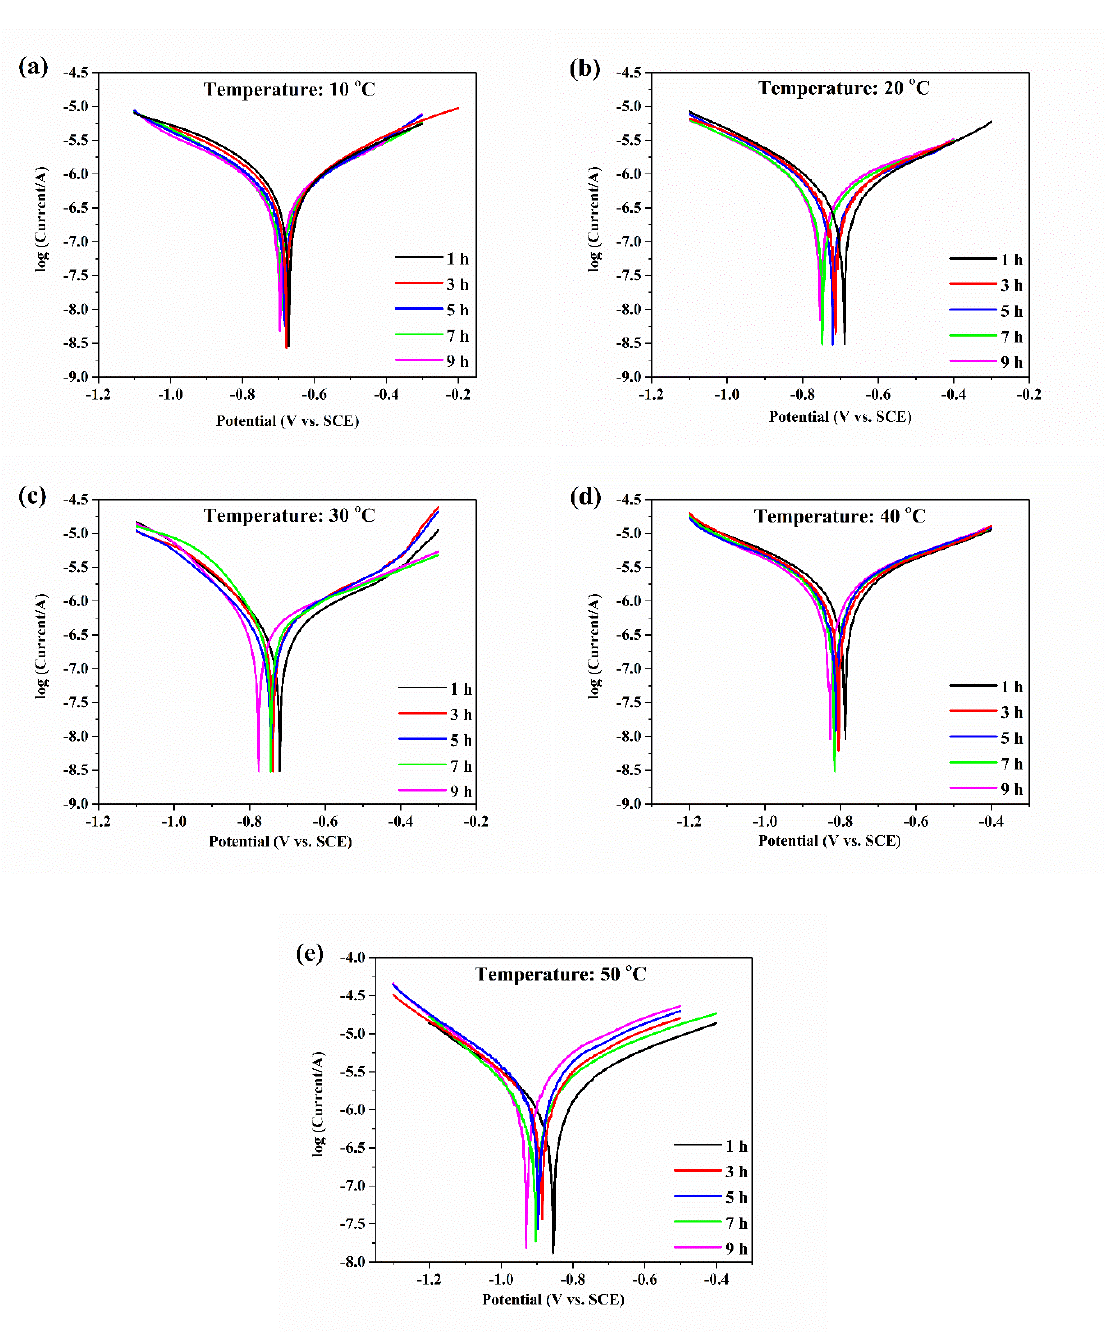
Figure 2. The Tafel polarization curves of aluminum electrodes in deionized water at 10 ( a ), 20 ( b ), 30 ( c ), 40 ( d ), and 50 °C ( e ).